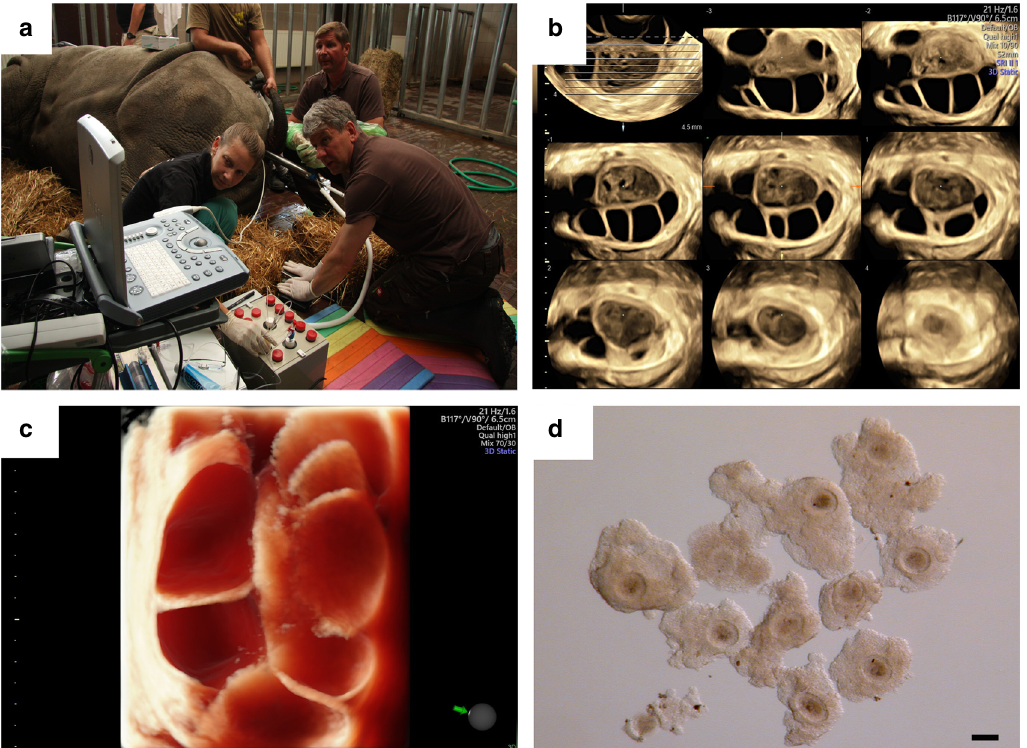
Fig. 1 Operational setting of the transrectal oocyte retrieval. a An anaesthetized white rhinoceros positioned in sternal recumbency during oocyte collection. One operator guides the OPU instrument inside the rectum directly to the stimulated ovary. The second operator injects the needle into the follicles under ultrasound guidance and performs the aspiration and repeatedly fl ushing the follicle up to ten times. The third operator replaces the full sterile 50-ml falcon tubes with an empty one. The 3D tomographic ultrasound image ( b ) generated with the portable 3D/4D ultrasound unit Voluson I (GE Healthcare, Solingen, Germany) shows different slices of the ovarian parenchyma which contain one central echogenic corpus luteum (white asterisk) and many anechoic follicles ranging from 4 to 20 mm in diameter. The 3D render mode ultrasound image ( c ) shows a virtual cut through the stimulated rhinoceros ovary. In this section eight different follicles are visible. d Ten rhinoceros oocytes after transrectal oocyte retrieval. Most of the oocytes collected had an intact cumulus oocyte complex besides the fact that the double-lumen aspiration needle used has a length of 950 mm and the vacuum applied was 100 mmHg. Bar 100 µ